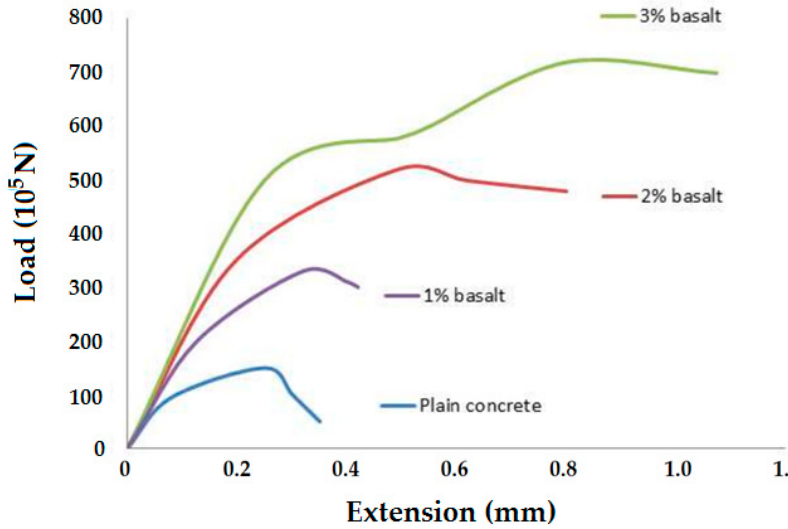
Figure 9. Load-extension curves from tensile testing of experimental concrete slabs.